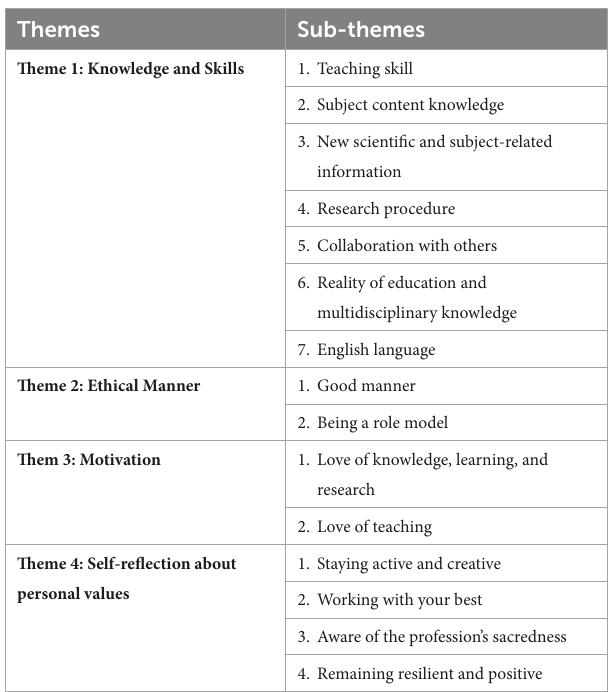
TABLE 2 Themes and subthemes for competencies of teacher